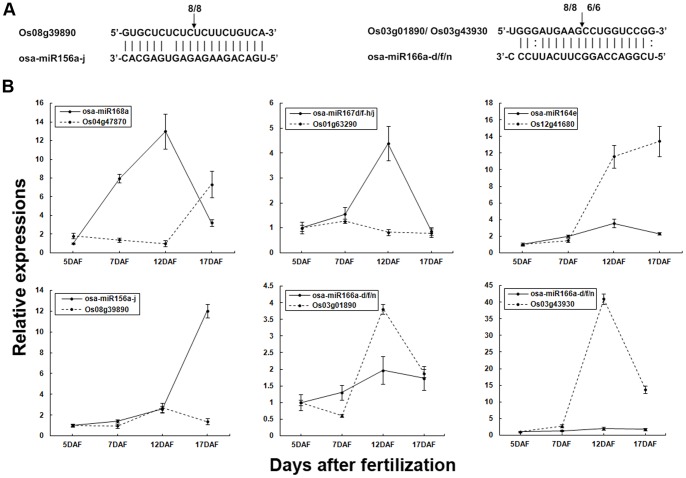
Validation and expression of selected miRNA target genes.(A) 5′-RLM-RACE analysis of the cleavage of target mRNAs by corresponding miRNAs. The arrows indicate the cleavage sites, and the numbers represent the frequency of the sequenced clones. (B) Expression profiling analysis of several target genes and their corresponding miRNAs in rice grain on different days after fertilization. Actin was used as a reference, and the expression levels of each of the target mRNAs were then compared with their expression at 5 DAF or 12 DAF, which was set to 1.0. Error bars indicate the standard deviation (±SD) of three replicates. Os04g47870 (PINHEAD) and Os12g41680 (no apical meristem protein) were confirmed to be targets of Osa-miR168 and Osa-miR164, respectively, in previous work [59]. Os01g63290 (transporter) was predicted to be target of osa-miR167d/f-h/j using psRNA Target (data not shown).